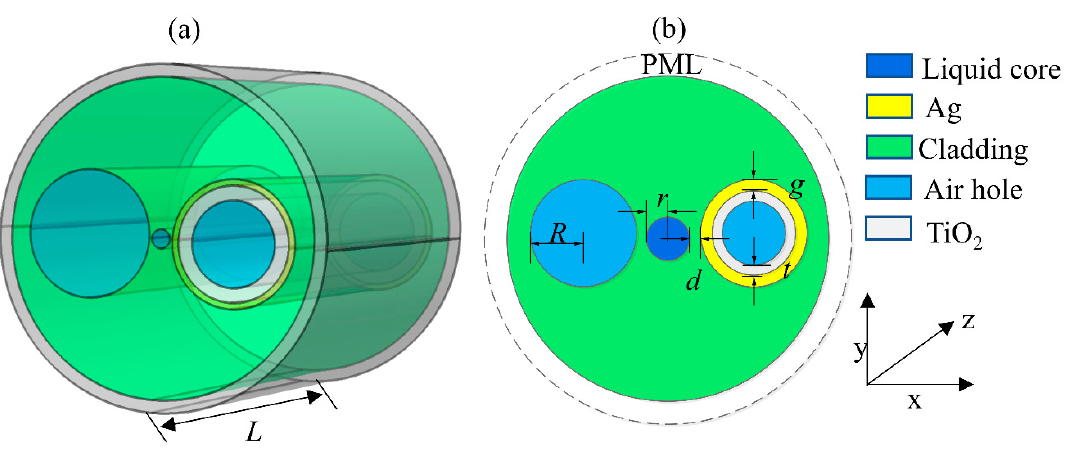
Figure 1. Three-dimensional (3D) ( a ) and cross-sectional ( b ) views of the proposed device. The outer Figure 1. Three ‐ dimensional (3D) ( a ) and cross ‐ sectional ( b ) views of the proposed device. The outer diameter of the cladding is fixed to 125 µ m and the thickness of the PML is 4 µ diameter of the cladding is fixed to 125 μ m and the thickness of the PML is 4 μ m.